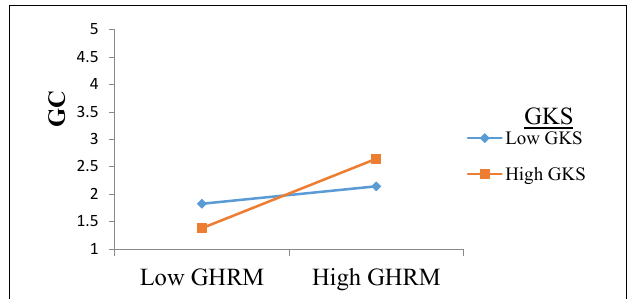
FIGURE 2 | Interaction effect of GHRM and green knowledge